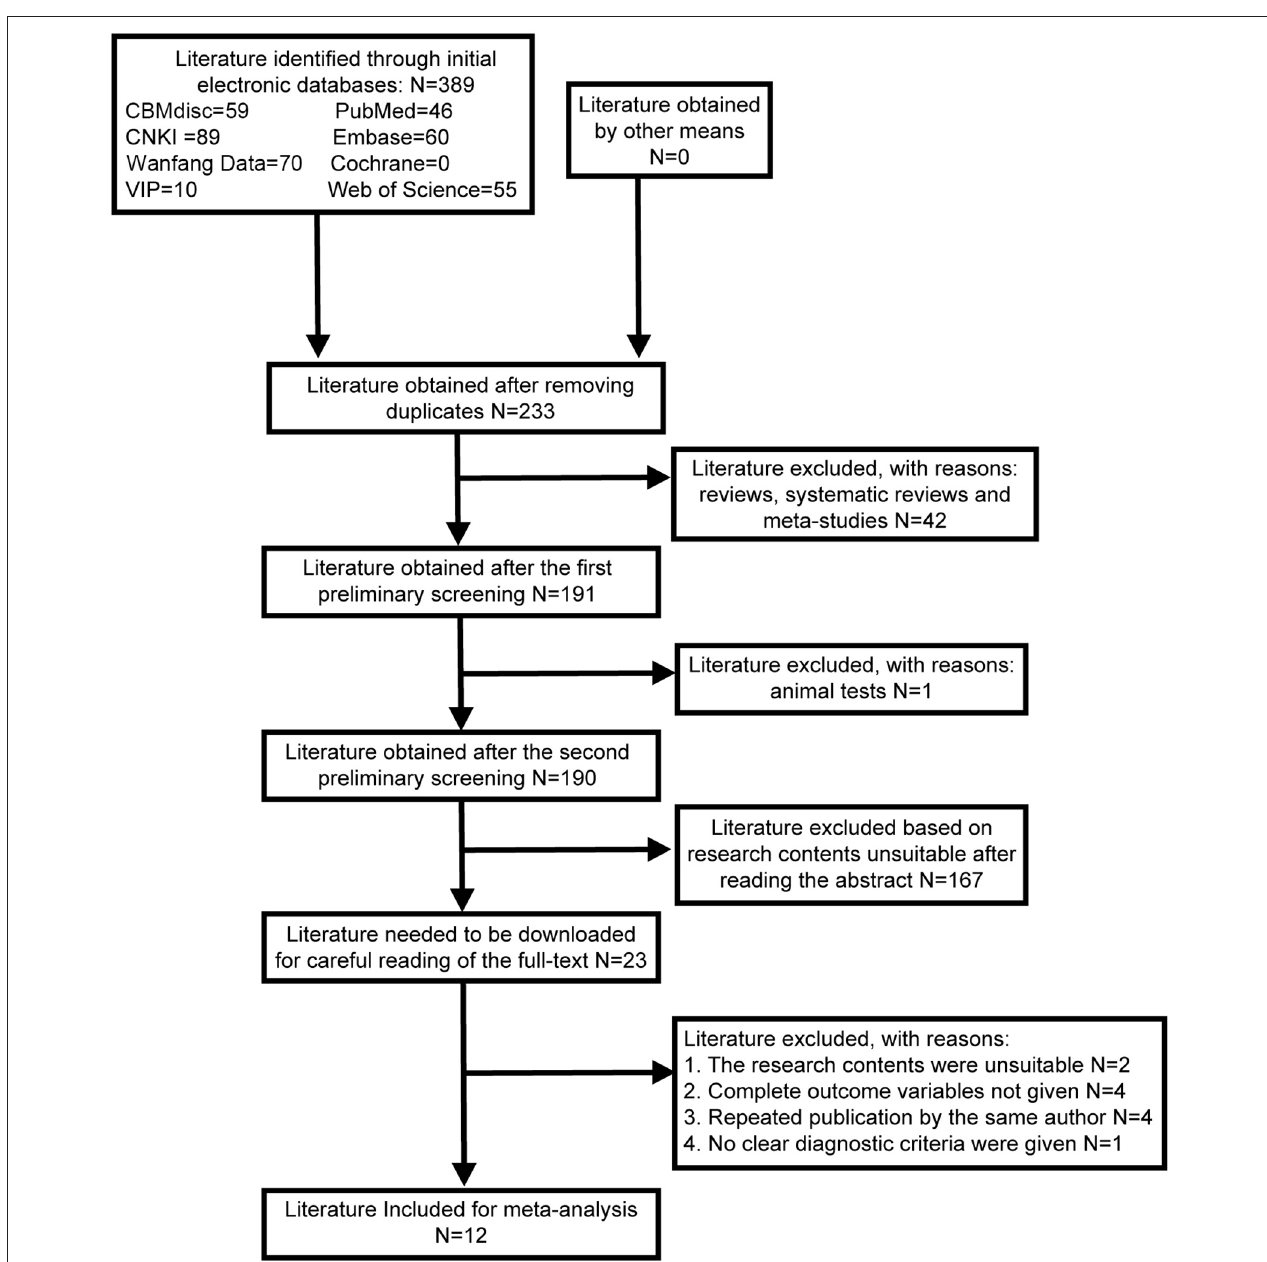
FIGURE 1 | Literature retrieval flow